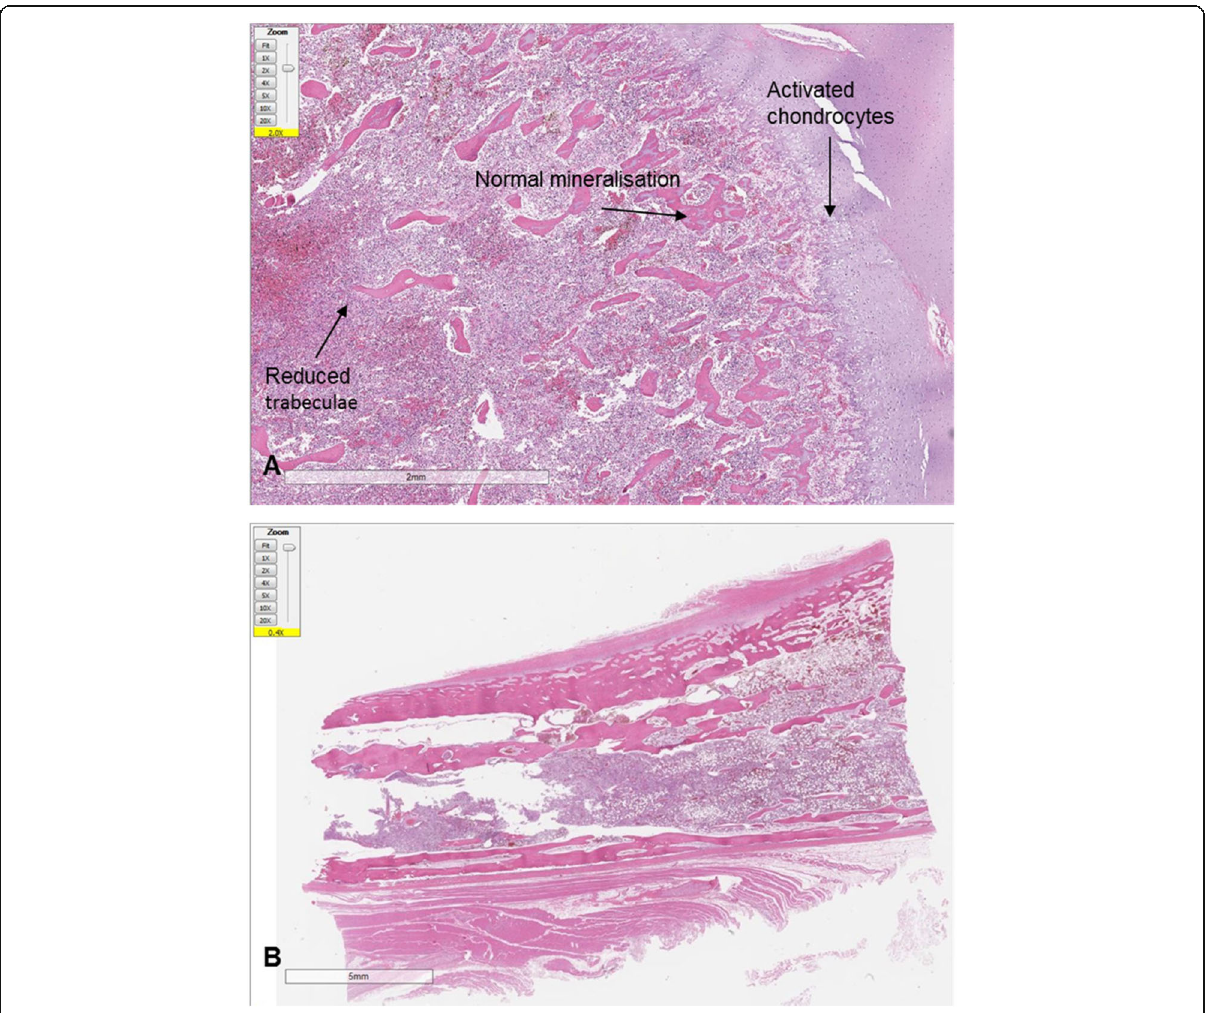
Fig. 2 Histological Findings. a Histology of the femur at 2x magnification using Haematoxylin and Eosin (H + E) staining. This shows activated and slightly irregular columns of chondrocytes , adequately mineralised trabeculae in the metaphyseal region of the endochondral ossification zone , but reduced number of trabeculae in the diaphysis (see arrows). b Histology of the rib at 2x magnification using H + E staining showing reduction in bony trabeculae of the